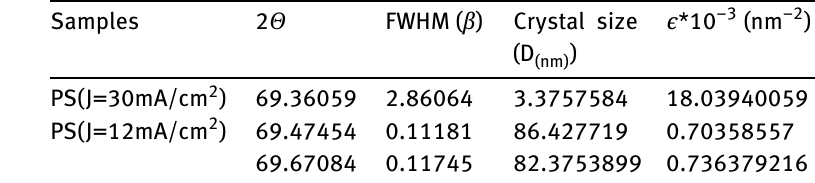
Table 1: Crystal size and strain for PS with different current densities at 30, 12 mA/cm 2 , 10 min. & HFc 40%.